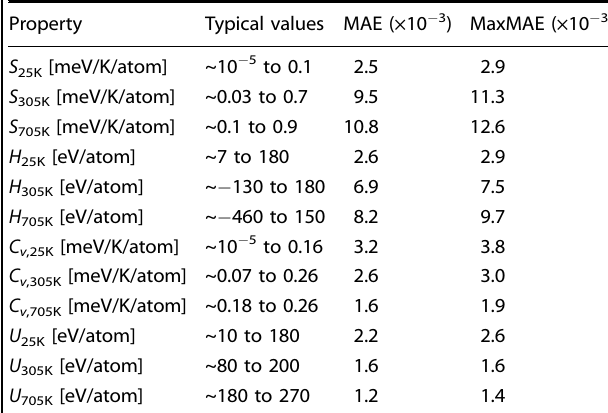
Table 2. MODNet errors on various vibrational properties. Property